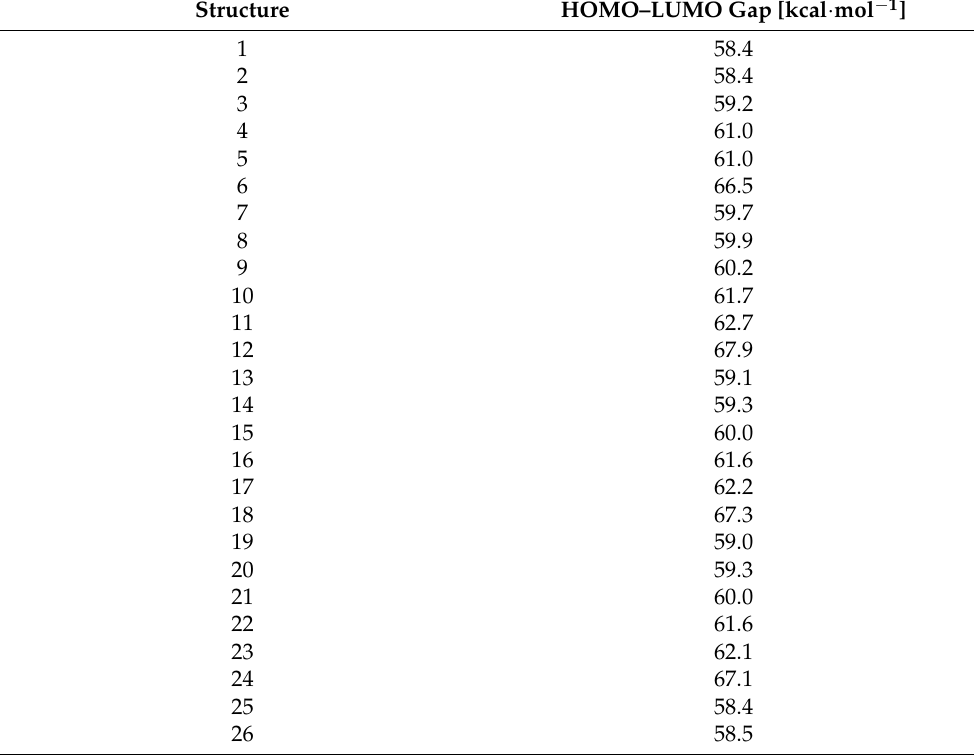
Figure 9. NCI plots for ( a ) 31 , ( b ) 32 , ( c ) 33 , ( d ) 34 , ( e ) 35 , and ( f ) 36 fagopyrin F conformers. Colors used for isosurfaces are: red for repulsive, green for dispersive, and blue for attractive interactions. Table 3. HOMO–LUMO gap energy for calculated fagopyrin structures.